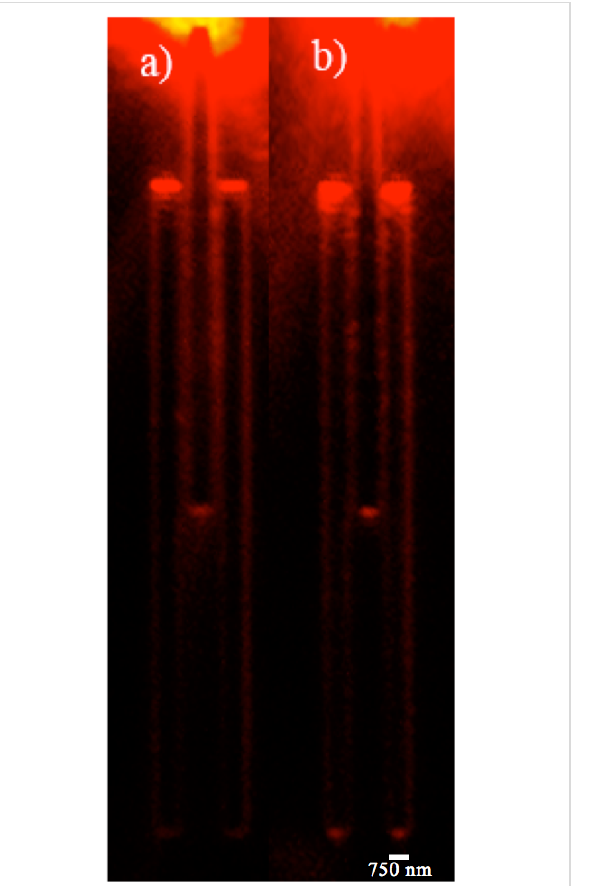
Figure 4: QD luminescence images of interferometers with 300 nm gap and 200 nm gap when excited via input arm with a 633 nm laser.